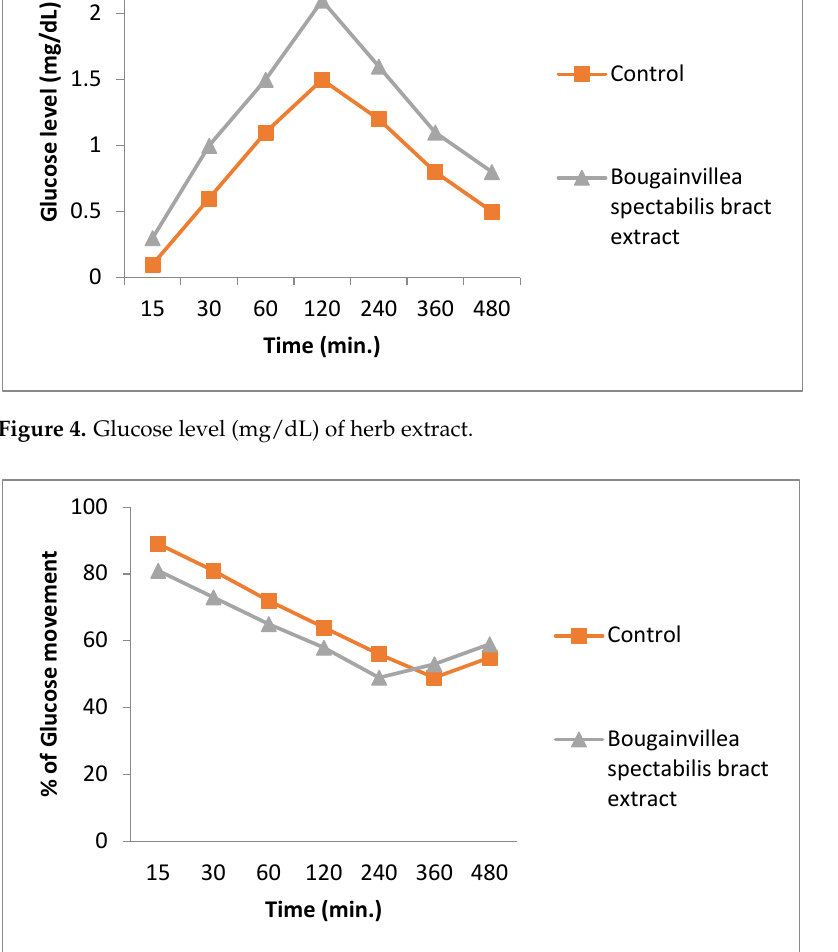
Figure 5. Percentage of glucose movement of herb extract.